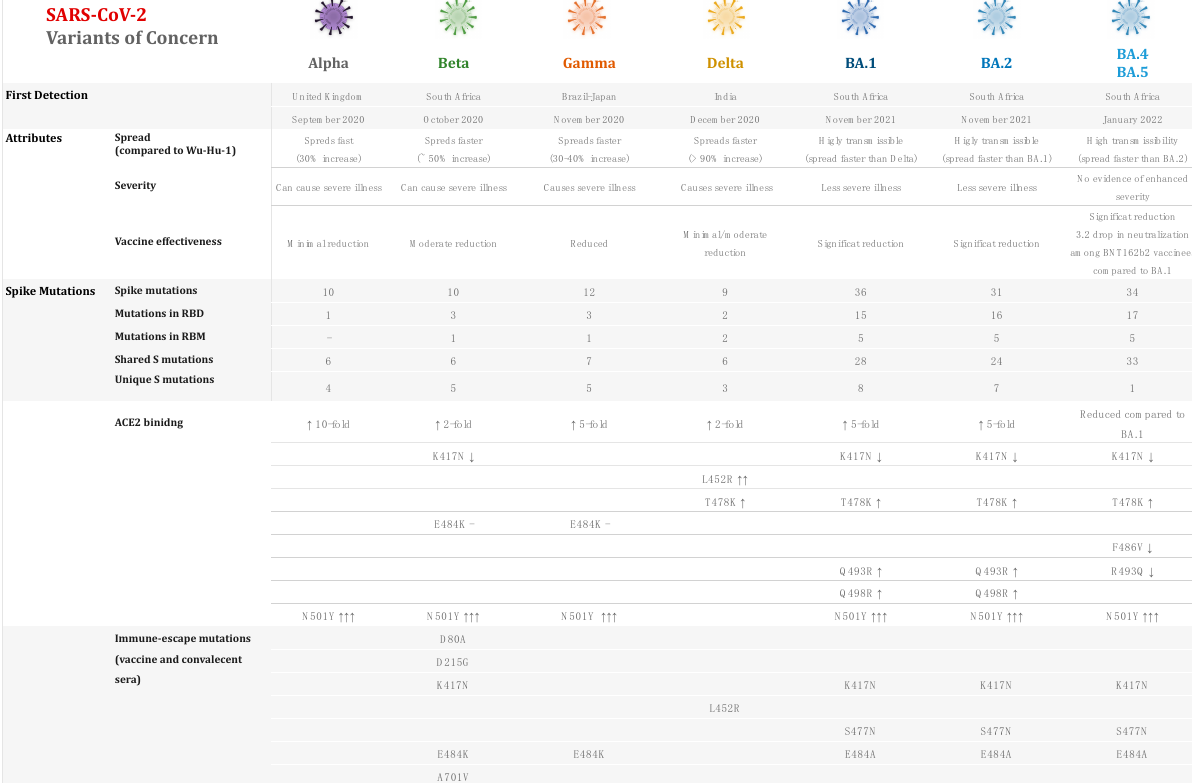
Figure 1. COVID-19 variants of concern (VOC), their origin, and characteristics. Arrows represent relative increase or decrease in the binding affinity to ACE2 receptor. R 0 is calculated as R 0 = β , where γ = 1/average infectious period and β is the trans- γ mission rate or the number of contacts of an infective case in a defined time